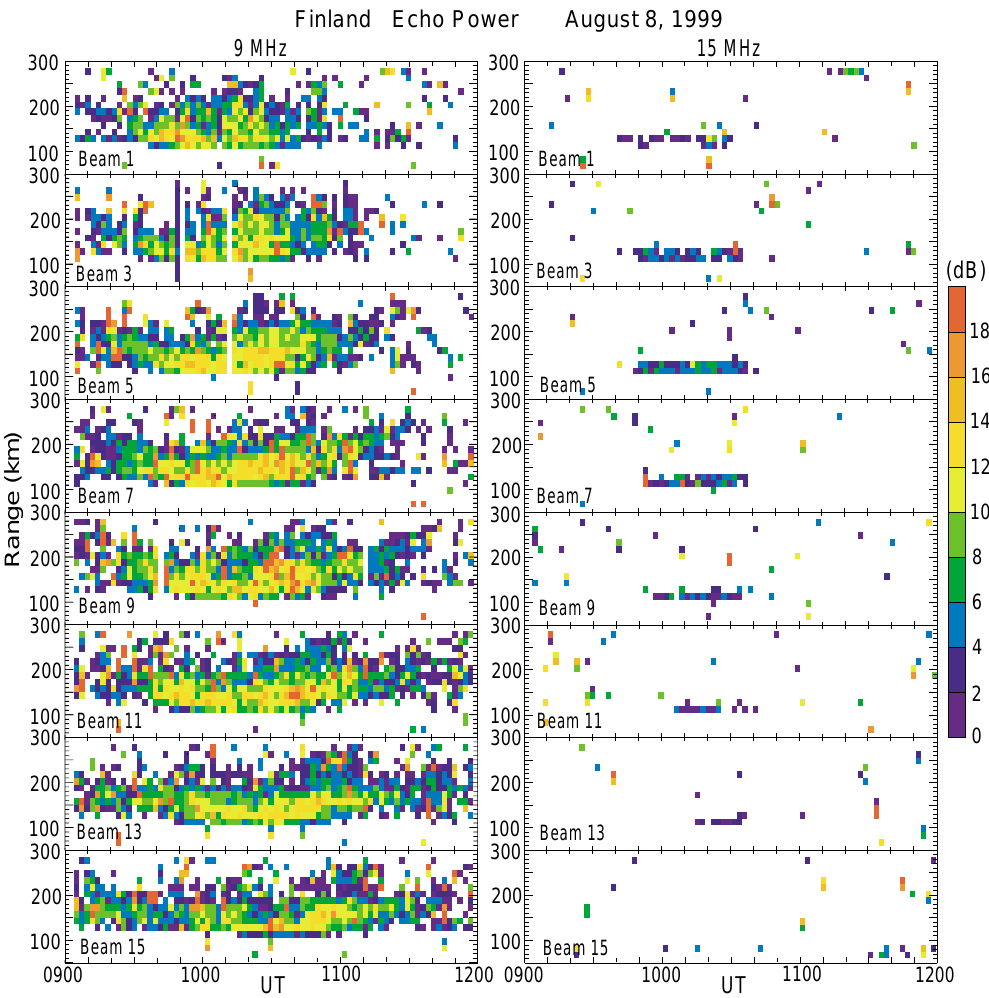
Fig. 4. Time and slant range distributions of echo power at (left) 9 and (right) 15 MHz on eight beams (beams 1, 3, ..., 15).